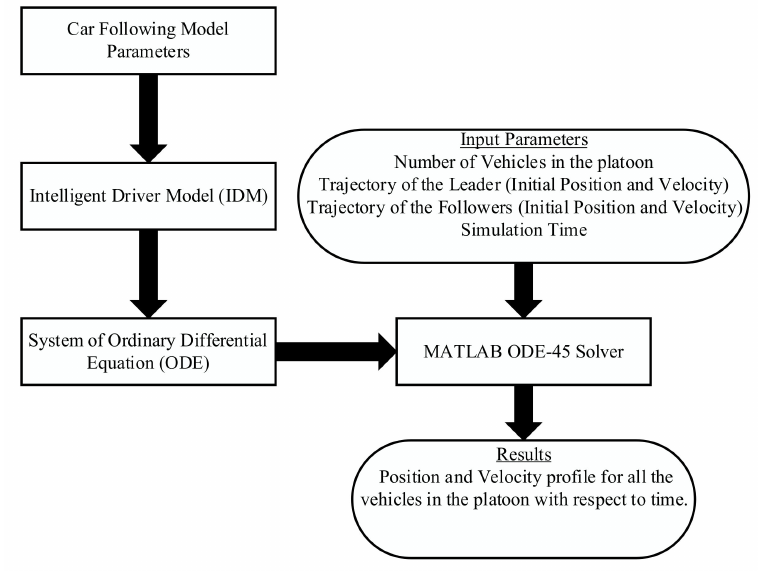
Figure 3. Integration of IDM in